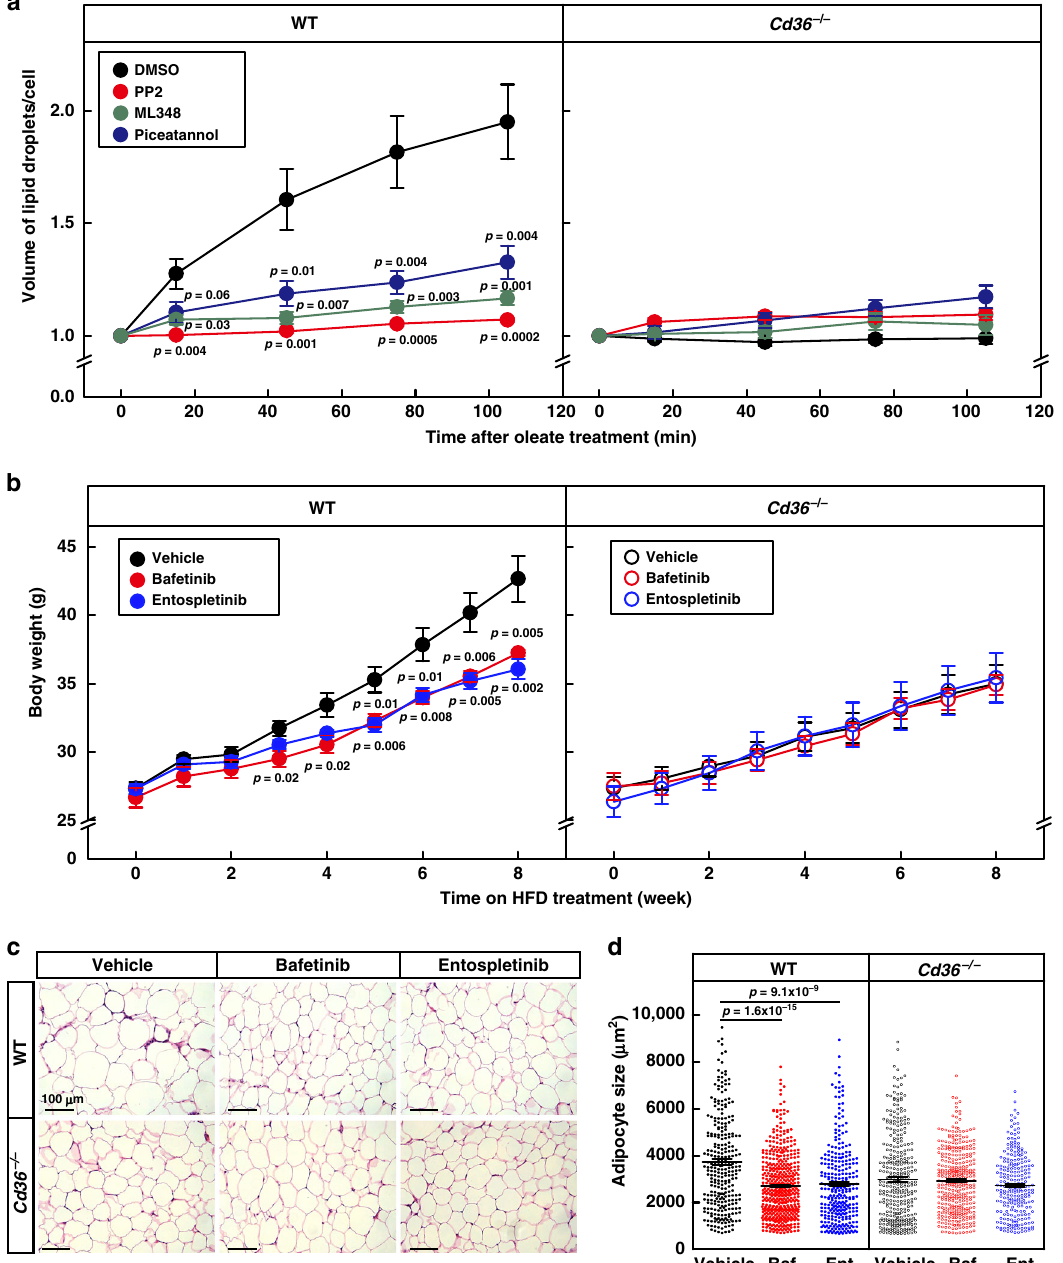
Fig. 7 Blocking endocytosis inhibits lipid droplet growth and HFD-induced obesity. a On the day of experiment, WT and Cd36 − / − adipocytes were pretreated with PP2 (20 μ M), ML348 (10 μ M), or piceatannol (40 μ M) for 1 h, then treated with oleate (100 μ M) and BODIPY 493/503 (0.1 μ g/ml), and subjected to live imaging on a Zeiss LSM-780 confocal microscope in a 3D Z-stack mode for 2 h. The number of cells was 12, 9, 8, and 10 for DMSO, PP2, ML348, and piceatannol-treated WT cells, and 8, 8, 8, and 10 for corresponding groups in Cd36 − / − cells, respectively. Total volume of lipid droplets in each cell was calculated. Each value represents mean ± SEM, and the volume at 0 min was normalized to 1.0. Two-sided Student ’ s t test was performed between DMSO- and PP2-, ML348- or piceatannol-treated cells. b – d WT and Cd36 − / − mice (8-week-old male, n = 6/group) were daily gavaged with vehicle (0.5% methyl cellulose), bafetinib (20 mg/kg), or entospletinib (10 mg/kg) at 7 pm and subjected to HFD feeding for 8 weeks. b Body weight of the mice was monitored every week. c , d Gonadal WAT was subjected to H&E staining, and representative pictures were shown ( c ). Scale bar, 100 μ m. Quanti fi cation of the surface area of adipocytes in gWAT by ImageJ. The size of each adipocyte was quanti fi ed by ImageJ and plotted as mean ± SEM from 287, 488, 305, 324, 362, and 218 cells, respectively d . Two-sided Student ’ s t test was performed between vehicle and bafetinib (Baf.), or entospletinib (Ent.) treated group, respectively. These experiments were repeated twice. Source data are provided as a Source Data fi